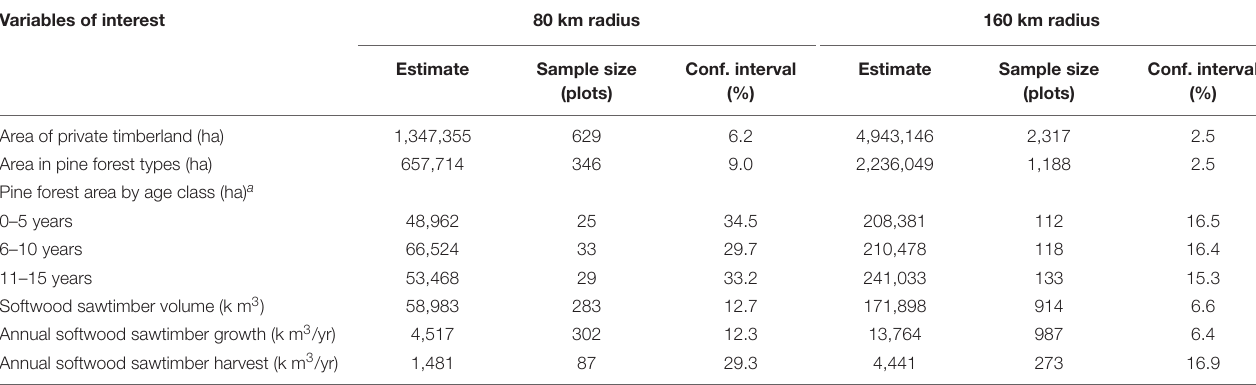
TABLE 1 | Example of variables of interest, sample size, and 90% confidence interval for FIA plot-based estimates for 80 and 160 km radii around an arbitrary